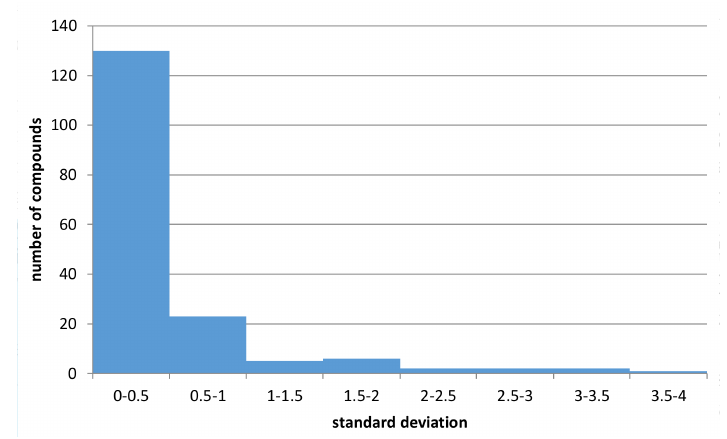
Figure 5. Standard deviation values of half-lifetimes between human, rat and mouse data.